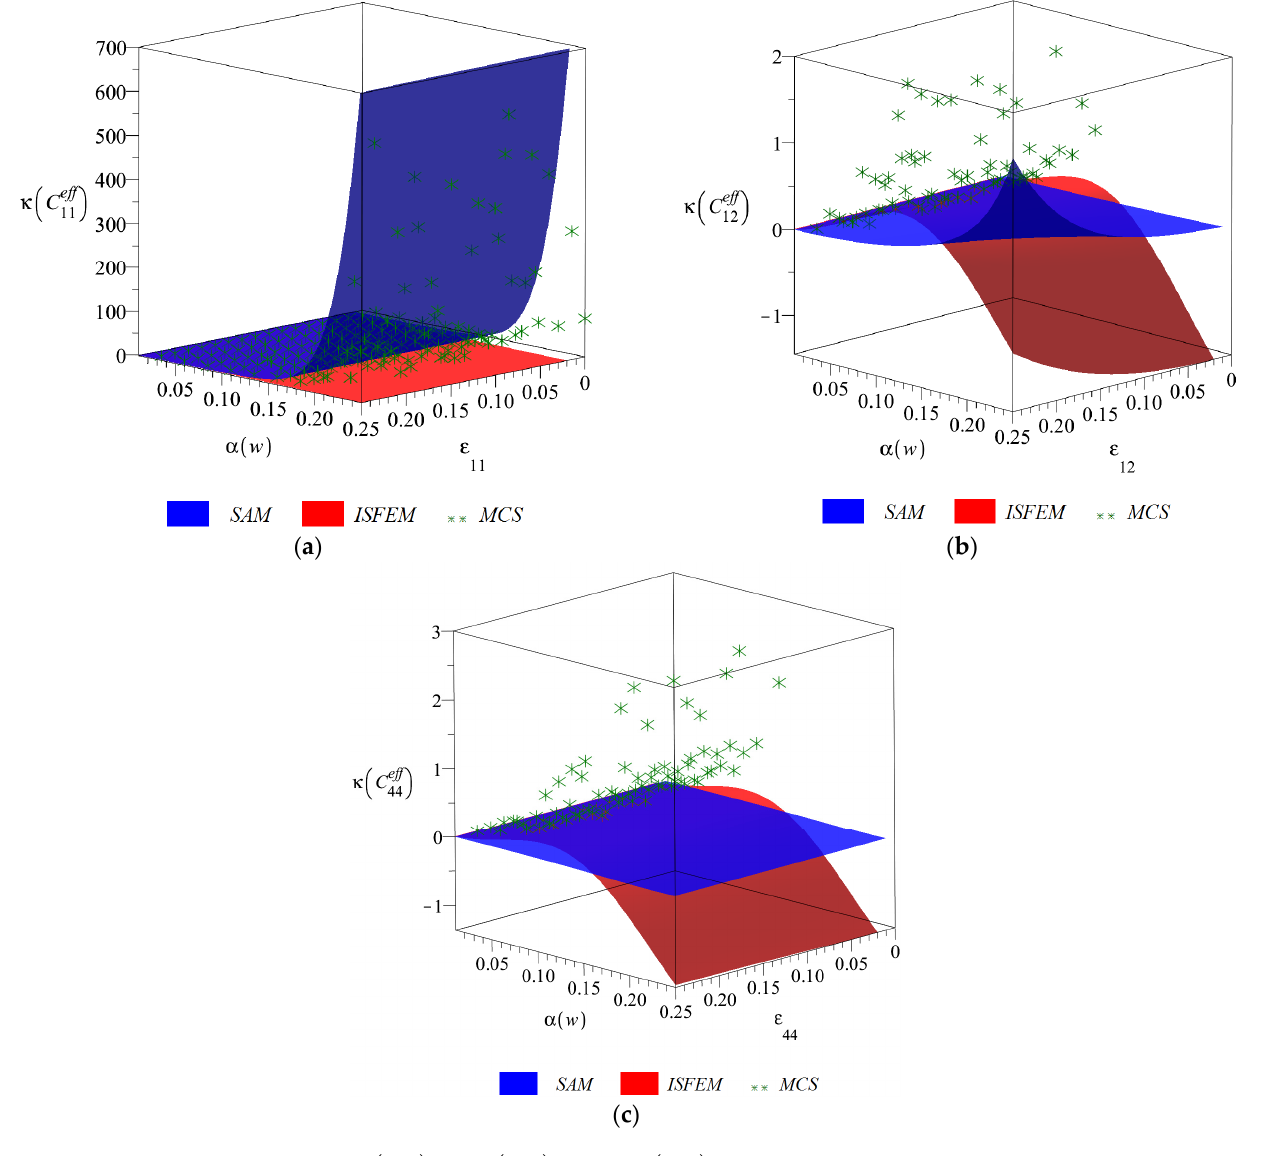
Figure 6. Kurtosis ( a ) κ (cid:3435) C 11eff (cid:3439) , ( b ) κ (cid:3435) C 12eff (cid:3439) and ( c ) κ (cid:3435) C 44eff (cid:3439) w.r.t. α (cid:4666) w ) and corresponding strain ε ij .